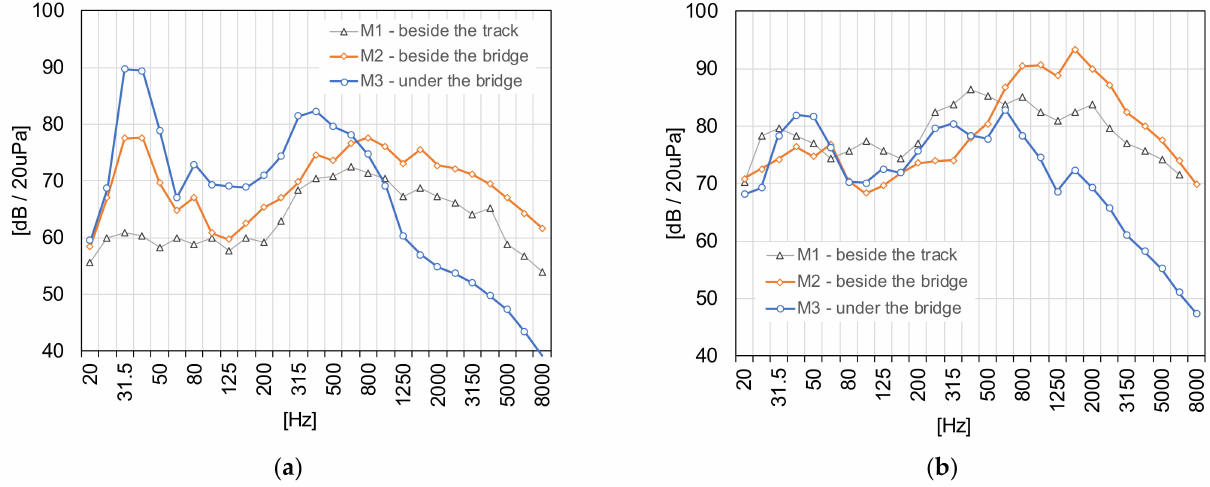
Figure 11. Levels of the acoustic pressure versus frequency bands during the passage: ( a ) cargo train (T1) at the speed of 40 km/h, ( b ) passenger train (T4) at the speed of 110